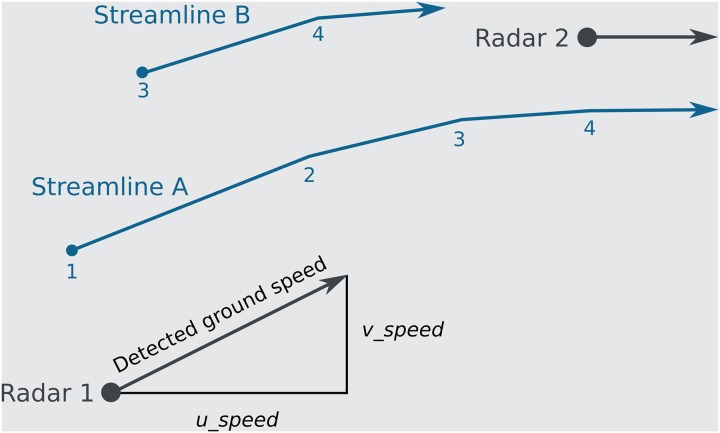
Schematic representation of the bird migration flow visualization.For each radar (Radar 1 & 2), the application will calculate a two-dimensional vector representing the u and v components of the detected ground speed of migration for that radar, altitude band and time interval (T0). Using the x and y positions of the radars, these vectors are interpolated using inverse squared distance weighting to create a vector field of interpolated ground speeds, expressed in pixels. Once the vector field is calculated, the animation starts. At animation frame 1, a streamline A (blue line) is initiated at a random position (blue dot) and the interpolated ground speed at that position is used to draw a line to a new position. This is repeated for each animation frame (2, 3, 4), creating a streamline through the vector field. At animation frame 3 an additional streamline B is initiated. After a fixed number of frames, the application will retrieve data from a new time interval (T1) and update the vector field, influencing the direction and speed of the streamlines.